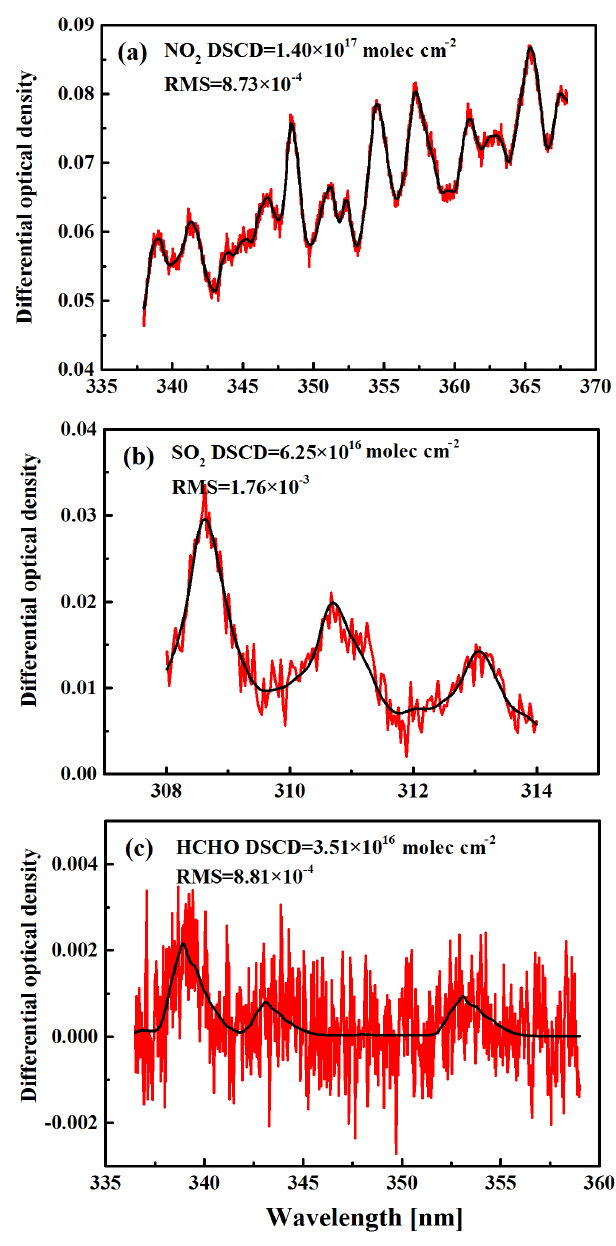
Figure 2. An example of DOAS fit for (a) NO 2 , (b) SO 2 , and (c) HCHO. The spectrum was taken on 1 December 2015 at 14:02LT with an elevation angle of 30 ◦ . Red lines show the mea- sured atmospheric spectrum after all other absorbers have been sub- tracted, and the black line shows the scaled reference absorption cross